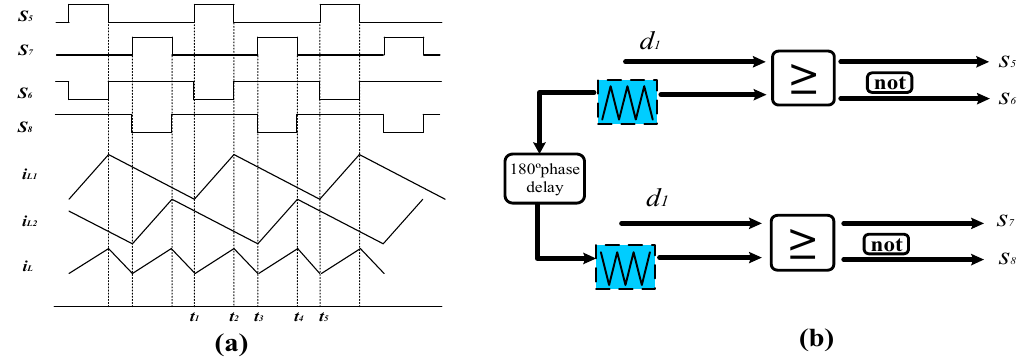
Figure 5. ( a ) The switch pulses and two inductor currents of the interleaved DC/DC converter; ( b ) The PWM modulation of the interleaved DC/DC converter.